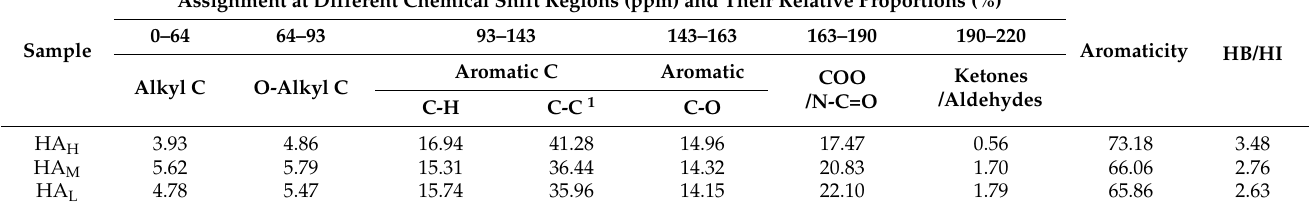
Table 3. Distribution of 13 C in resonance intervals (ppm) of CP/TOSS, CP/TOSS with DD NMR C intensity in different regions of NMR spectra of HA fractions and their reaction derivatives.